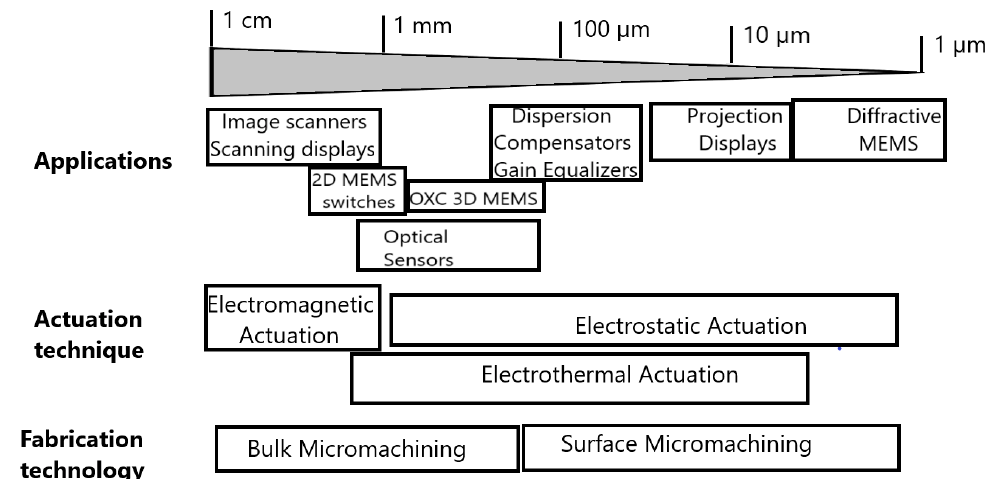
Figure 1. Applications, actuation mechanisms, and fabrication technologies for scanning micromirrors.